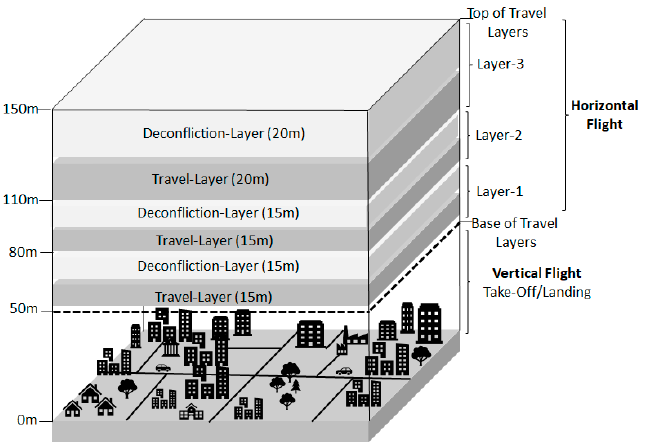
Figure 11. Schematic of airspace layering structure with three pairs of travel / deconfliction layers.